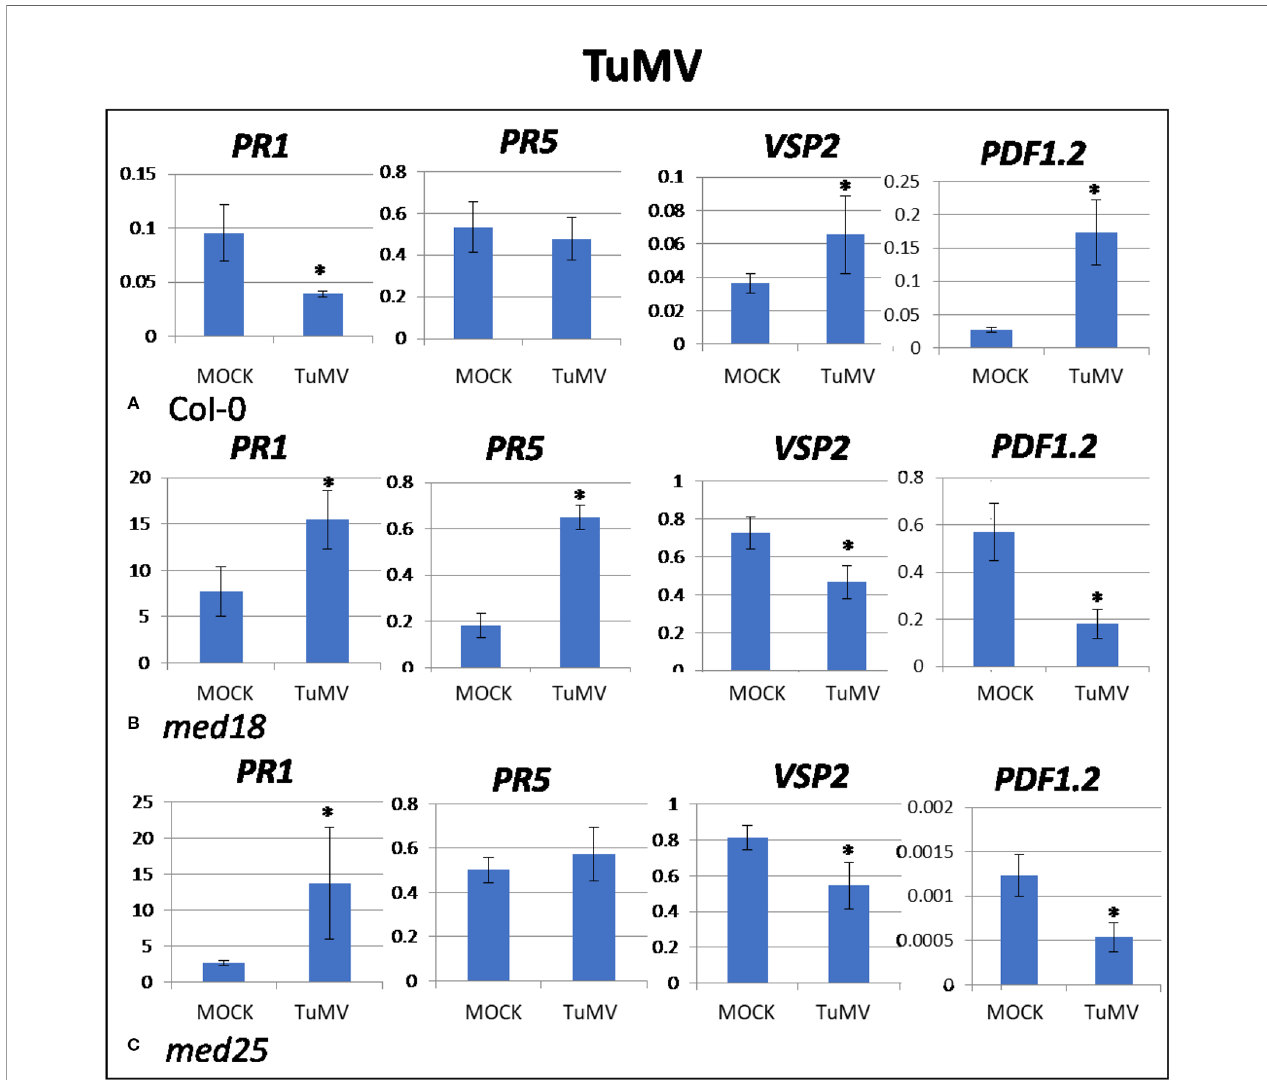
FIGURE 2 | Quantitative reverse transcriptase PCR (qRT-PCR) assays with SA- ( PR1, PR5 ) and JA- ( PDF1.2, VSP2 ) signaling marker genes of Arabidopsis plants inoculated with TuMV. Shown on the Y axes are mean ± SE values of transcript abundances relative to housekeeping ACTIN genes for (A) wild-type Col -0, (B) med18 , and (C) med25 plants at 2 days after inoculation. Asterisks indicate signi fi cant ( P < 0.05) induction or repression of each gene by comparing the means of mock-inoculated to TuMV-infected